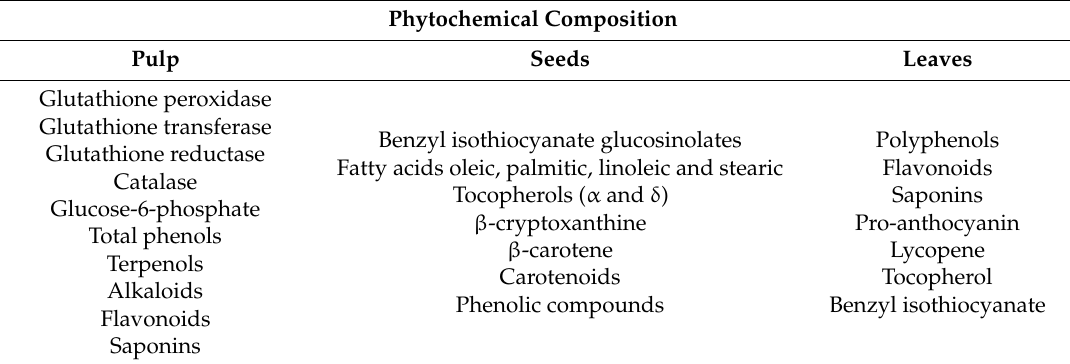
Table 3. Main phytochemical compounds present in C. papaya L. (papaya): ripe fruit pulp, seeds and leaves